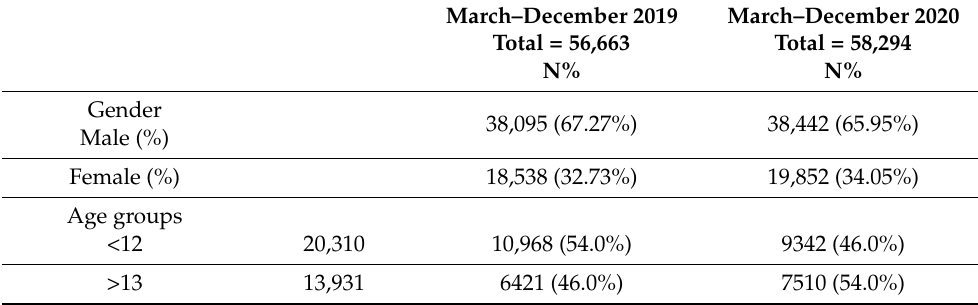
Table 1. Demographic variables of